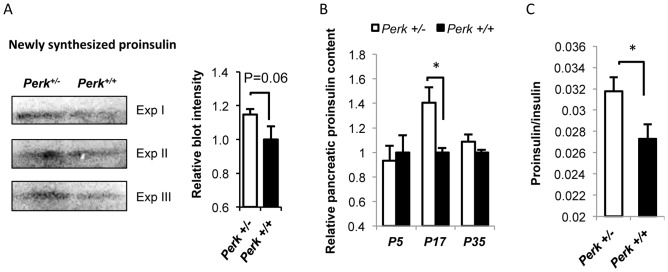
New proinsulin synthesis and mature proinsulin level were up-regulated in P17 Perk+/− mice.A. Newly synthesized proinsulin in mouse islets measured by western blot. Mice are postnatal 17 days. 10 µg/ml puromycin was added 15 minutes before protein samples were harvested. Left panel showed representative blots probed with anti-puromycin and co-localized with proinsulin C-peptide. Right panel showed quantification of blot intensity relative to Perk+/+. (n for Perk +/−, Perk+/+  = 5, 4). B. Total pancreatic proinsulin content of Perk+/− mice relative to Perk+/+ at various postnatal stages. Shown are means ± SEM (n for Perk +/−, Perk+/+  =  8, 8 (P5); 8,7 (P17); 18, 17 (P30). *P<0.05). C. Proinsulin and insulin were measured in the pancreatic samples harvested from P17 mice and proinsulin/insulin ratio was calculated. Shown are means ± SEM (n for Perk +/−, Perk+/+  = 8,7. *P<0.05).